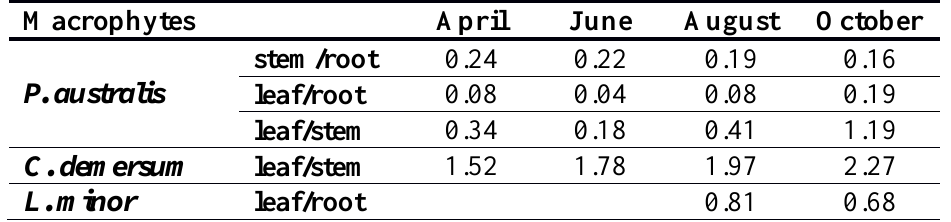
Table 5. Seasonal changes in the translocation ability (TA) of macrophytes tested for Cr